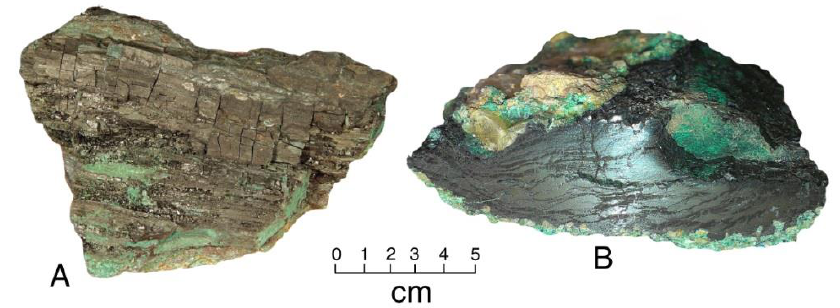
Figure 16. Triassic wood from the Nacimienento Mine, New Mexico, USA. ( A ) Specimen shows carbonized wood in sandstone matrix stained green from malachite; ( B ) Polished sawn surface. Wood has been replaced by primarily by chalcocite, and is enclosed within malachite-bearing sandstone. Malachite, azurite are alteration products that are visibly abundant in sandstone adjacent to the fossils wood, but their accurate detection in EDS spectra is impossible because the presence of relict carbon in the fossil wood obscures the possible presence of these carbonate minerals. Likewise, chryscolla (CuO·SiO 2 ·2H 2 O) does not yield a recognizable EDS spectrum because of the high silica